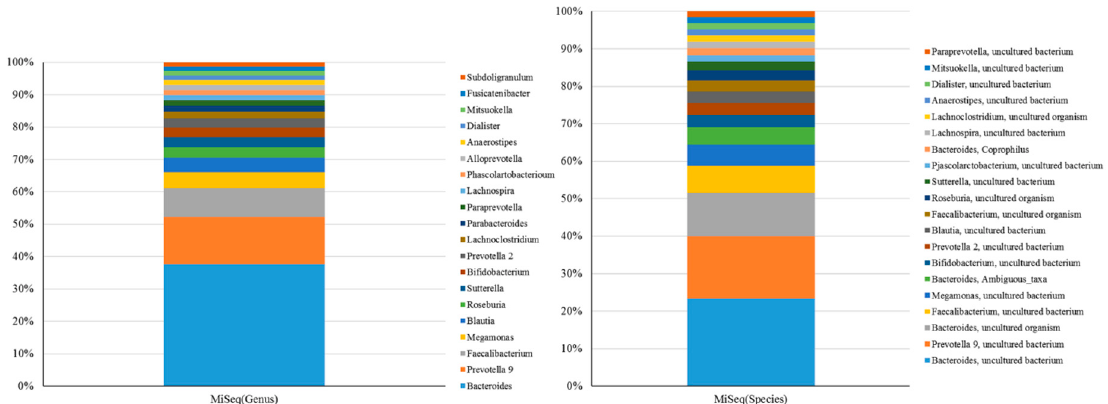
Figure 5. Composition of the 20 most abundant OTUs at genus or species level identified by mapping 16S rRNA gene amplicons sequenced using short-read sequencer against the SILVA reference database.